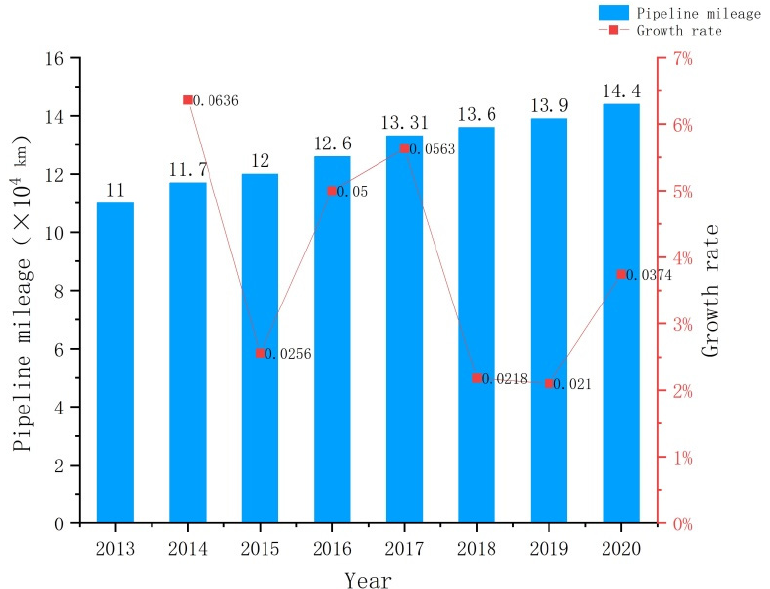
Figure 1. Pipeline mileage and growth rate in 2013–2021.